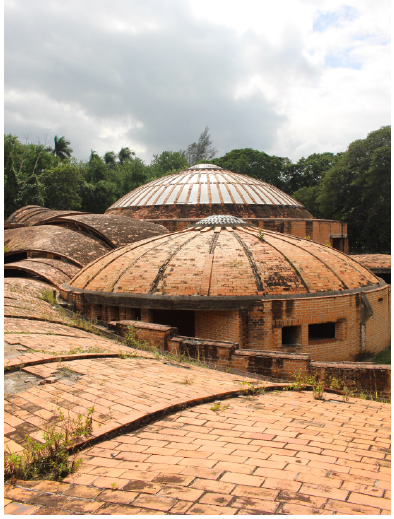
Figure 2. Selection criteria for appropriate documentation methods, based on research done by